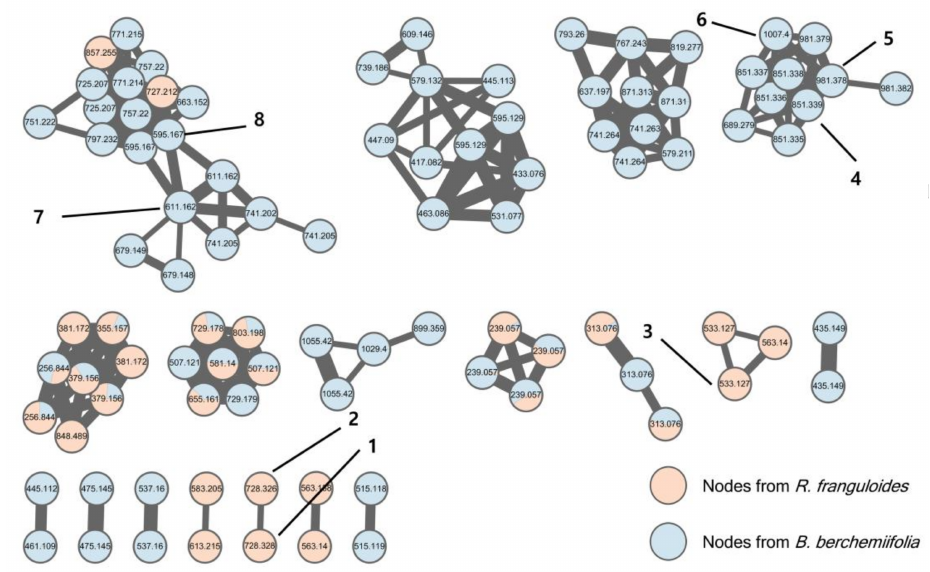
Figure 2. MS/MS molecular network of R. franguloides and B. berchemiifolia fruit extracts. Red nodes represent ions from R. franguloides ; blue nodes represent ions from B. berchemiifolia . Only clusters containing at least two nodes are